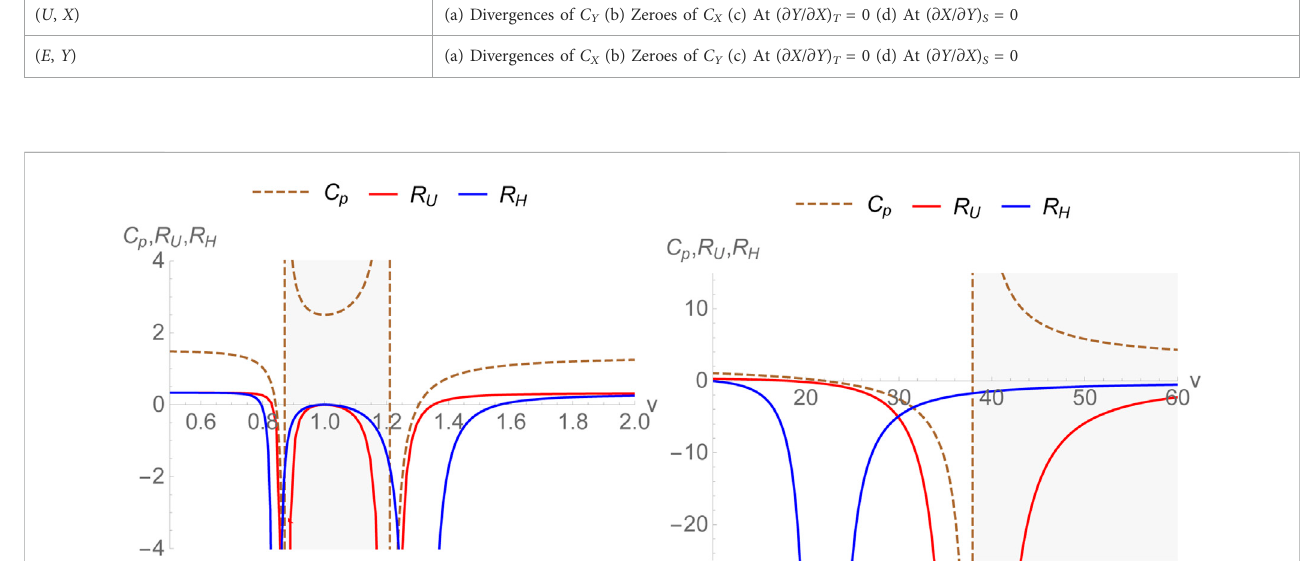
FIGURE 1 Thermodynamic curvatures R U , R H and speci fi c heat C P for the van der Waals fl uid plotted versus speci fi c volume with a = 2, b =1 below the critical temperature. The region(s) with negative bulk modulus are shaded in